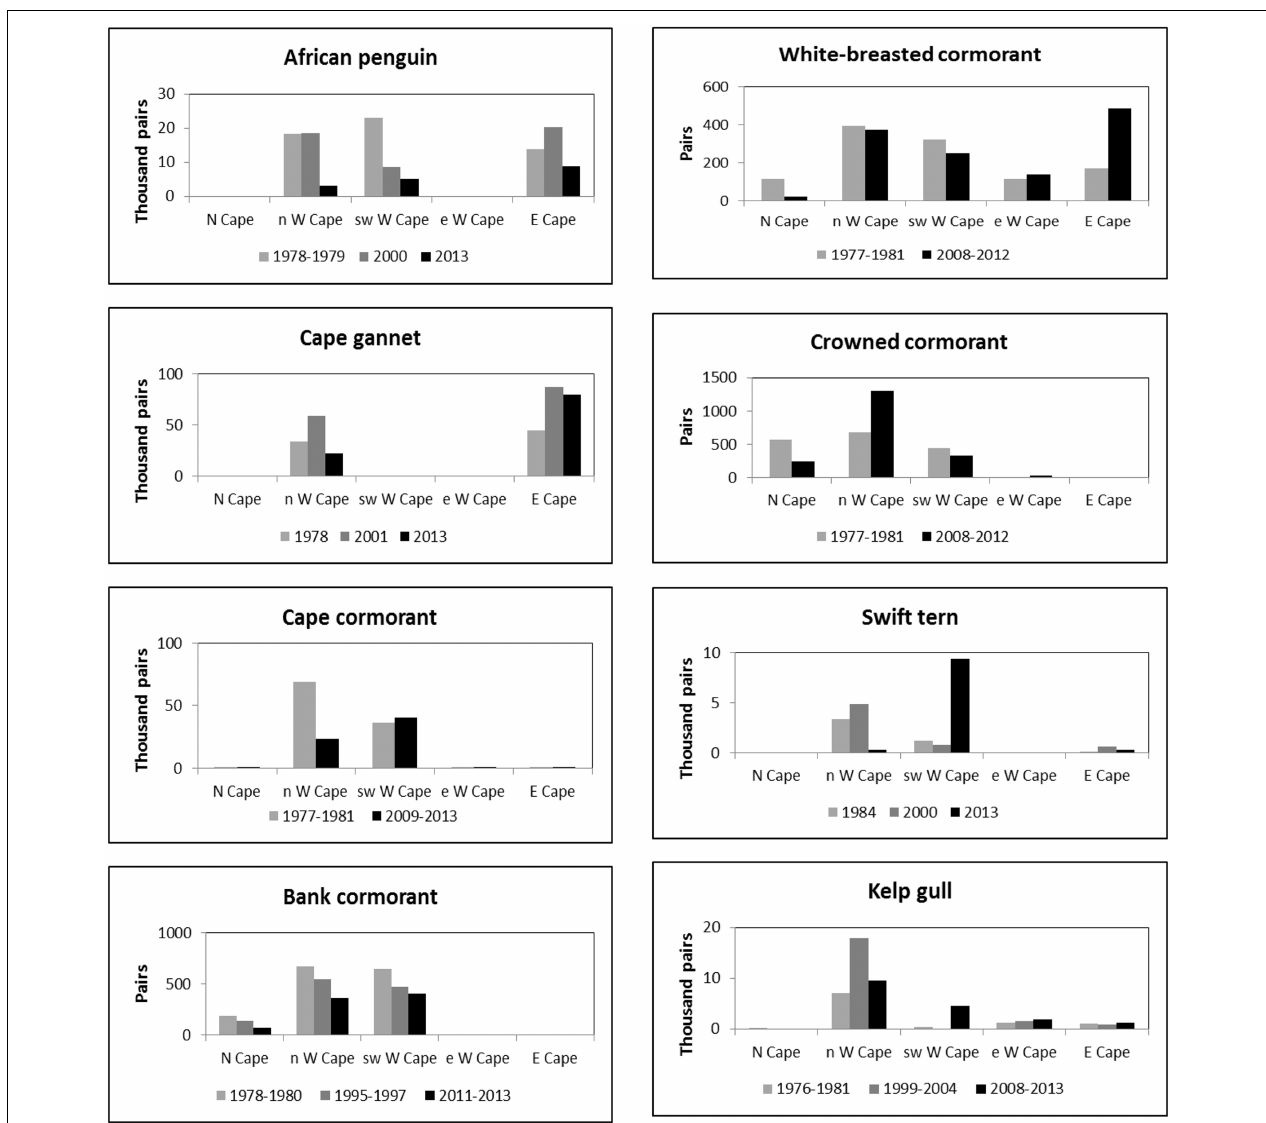
FIGURE 2 | Numbers of eight seabird species breeding coastally in five regions of South Africa’s west and south coasts in different periods in which entire populations were estimated.